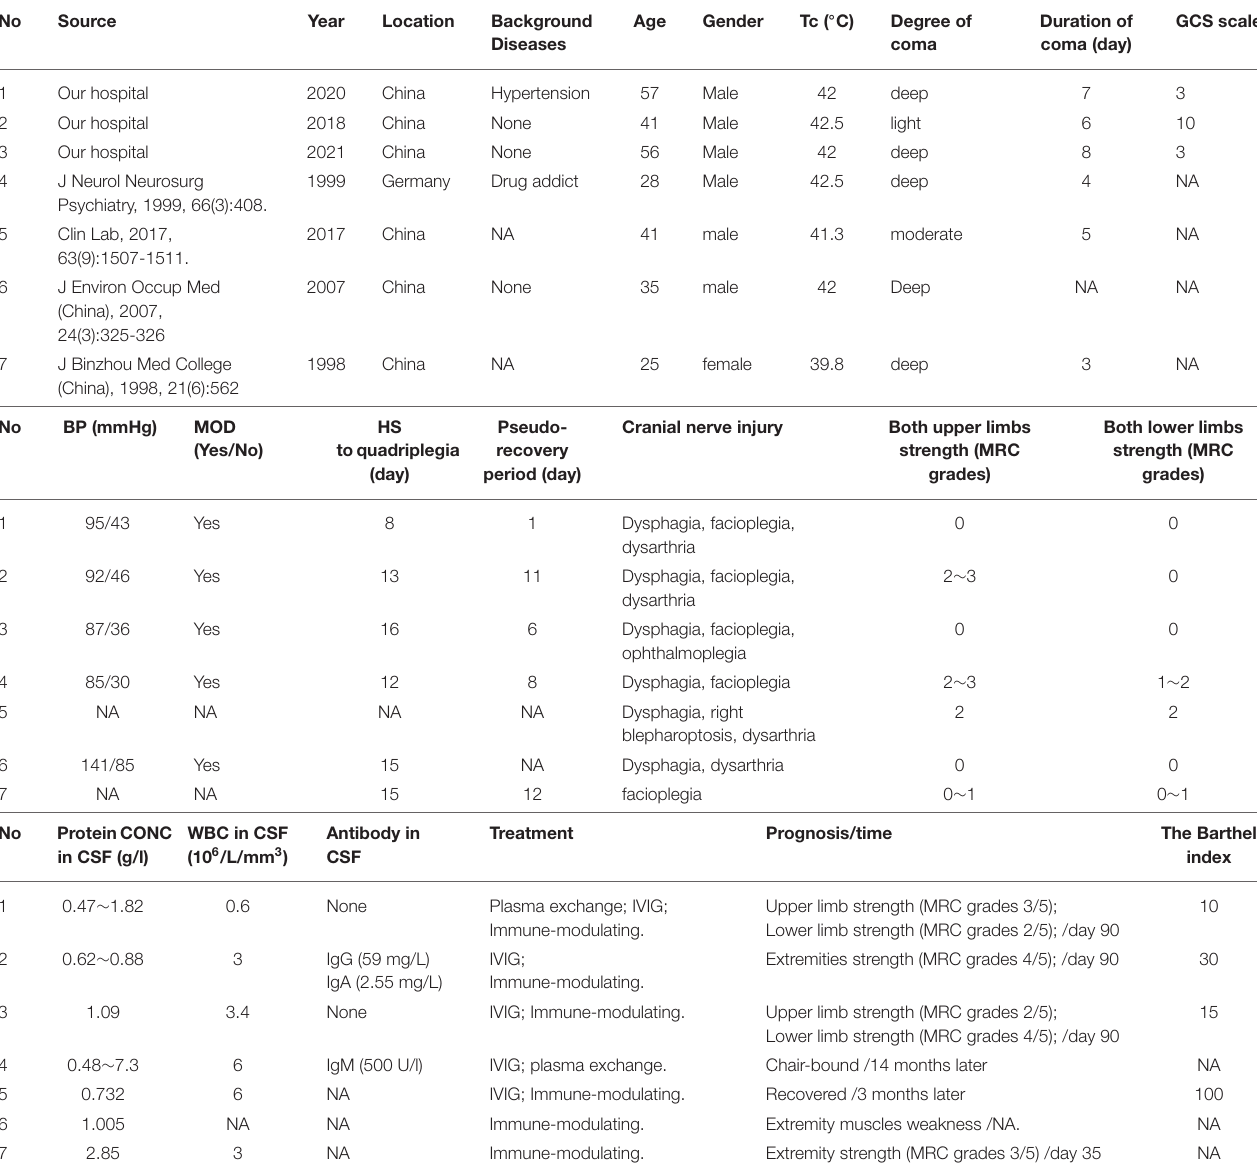
TABLE 1 | Detailed clinical data of patients with Guillain–Barre syndrome induced by heat stroke.